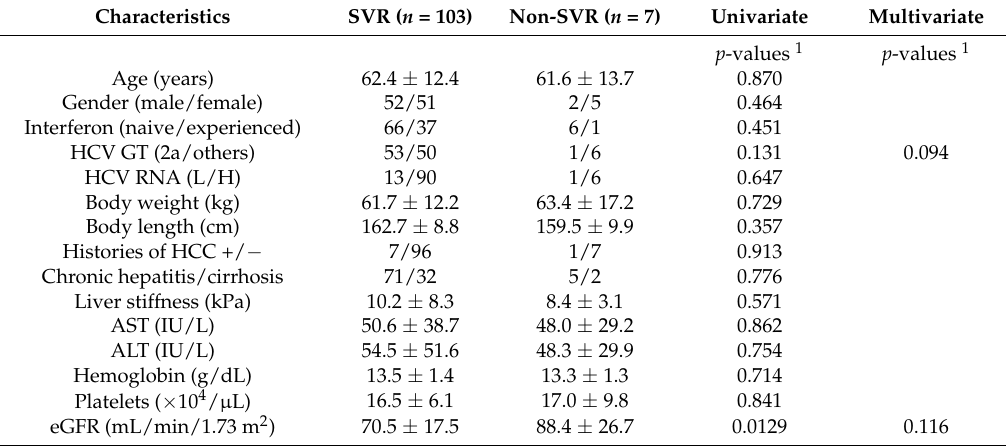
Table 3. Univariate and multivariate logistic regression analysis of predictors of SVR12.